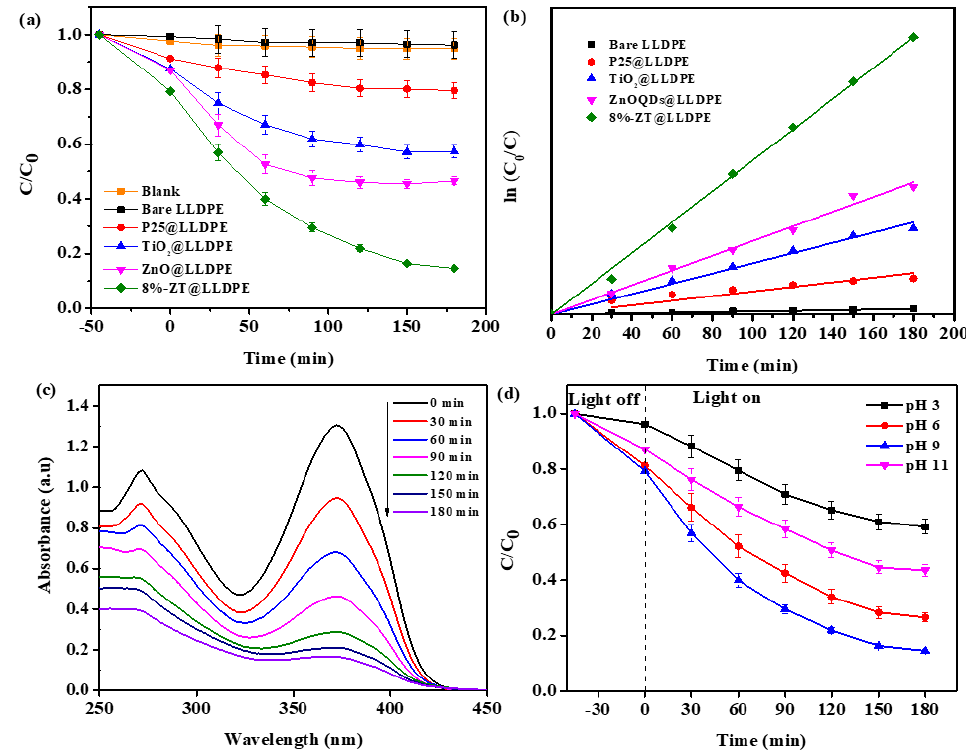
Figure 7. ( a ) Photocatalytic degradation of TC with various LLDPE hybrid films ([TC] = 40 mg/L; pH 9; lamp power: 48 W); ( b ) the rate curve based on the Langmuir–Hinshelwood kinetic model; ( c ) UV spectral changes during photocatalytic degradation of TC using 8%-ZT@LLDPE composite ([TC] = 40 mg/L; pH 9; lamp power: 48 W); and ( d ) effect of initial pH of the solution ([TC] = 40 mg/L; lamp power: 48 W). Table 1. Kinetic data for the photodegradation of TC using LLDPE hybrid films.